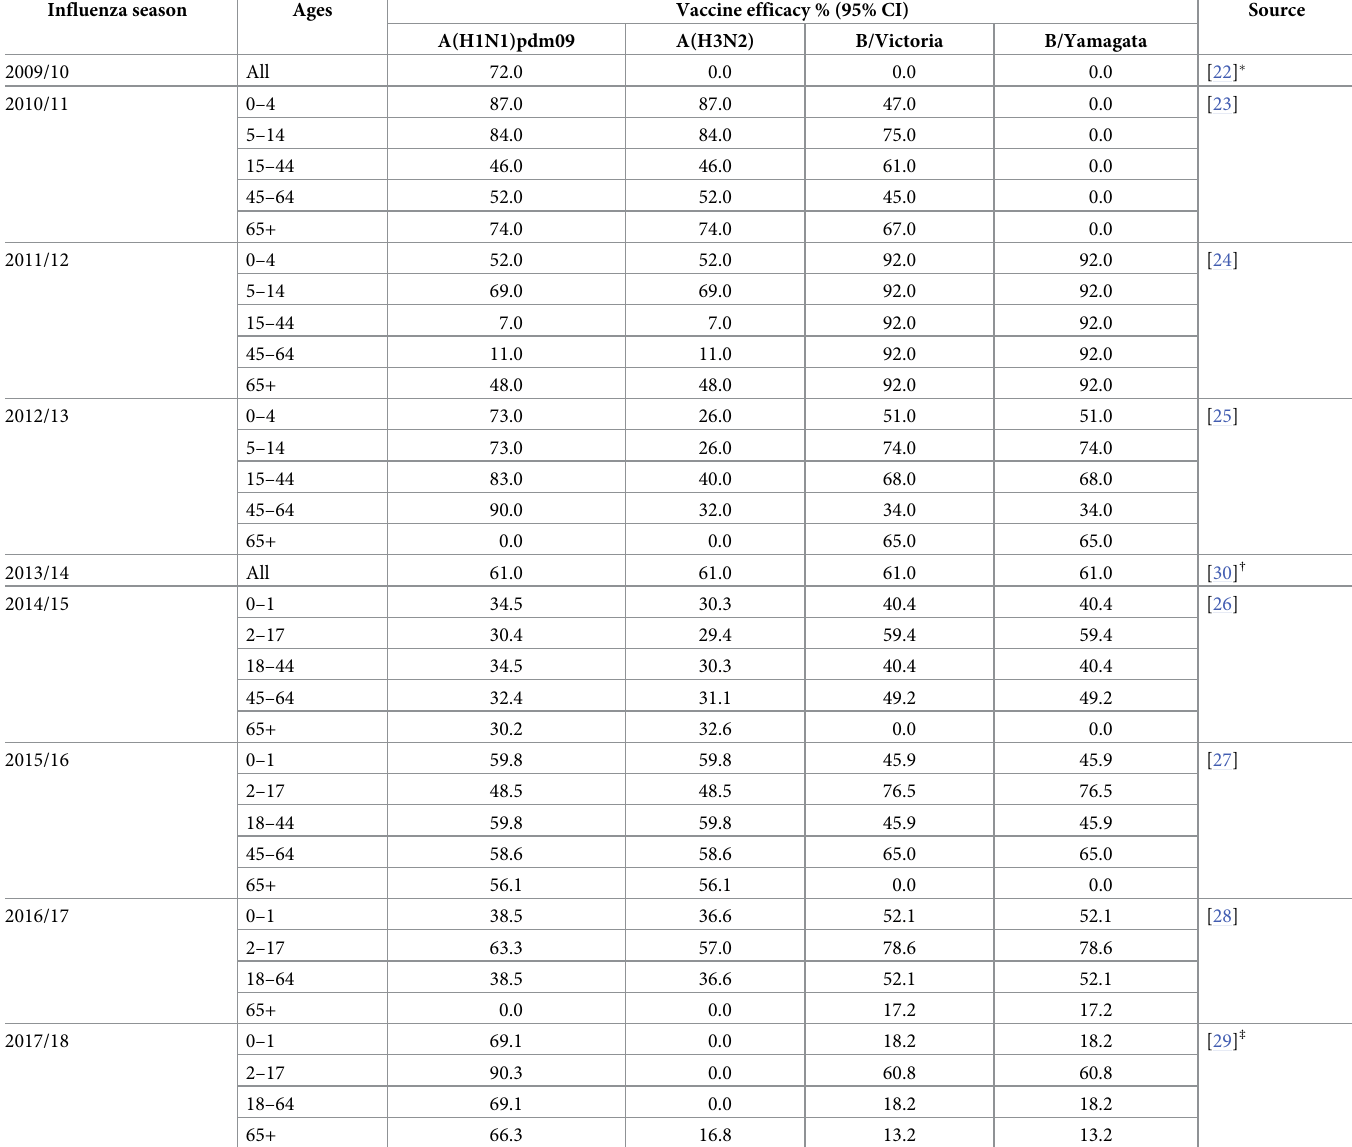
Table 1. Age adjusted, influenza vaccine efficacy point estimates (by influenza season, age and strain type). All estimates are presented as percentages. The empirical adjusted influenza vaccine efficacy estimates by influenza season and strain type (presented in the S1 Text, Table A) did not provide individual vaccine efficacy estimates for each influenza A subtype and influenza B lineage. We therefore implemented a series of assumptions to produce the strain-specific, vaccine efficacy point estimates used within our study (described in Section 1.5 of the S1